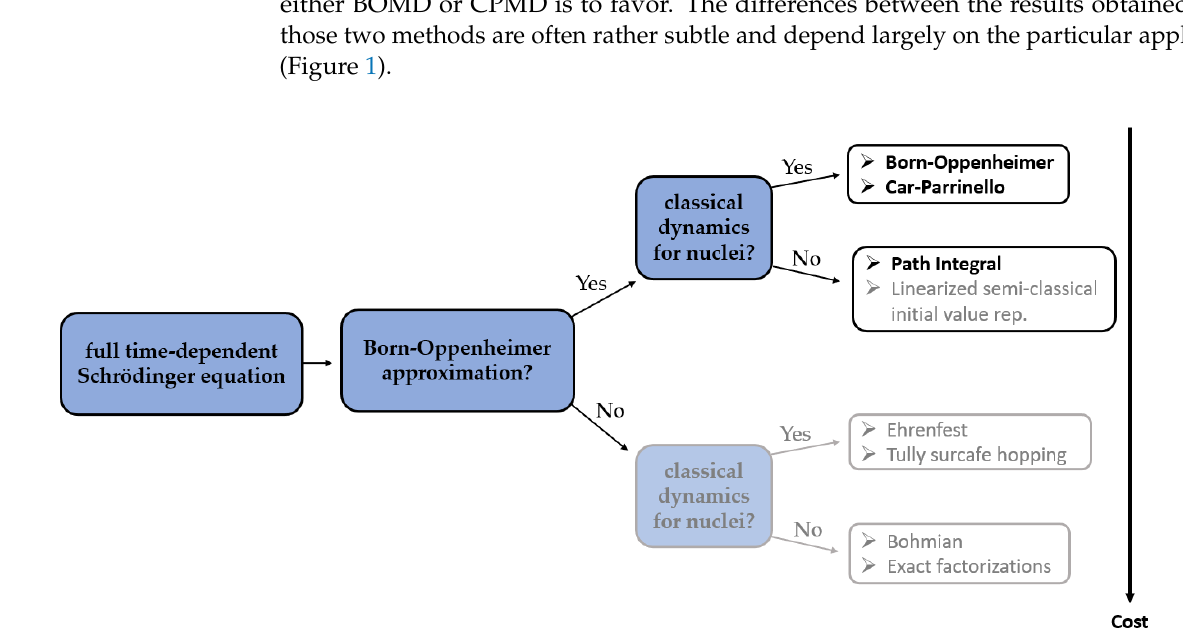
Figure 1. The major differences between the methods of aiMD simulations [18]. Bolded methods have already found their application in combination with NMR parameters calculations.